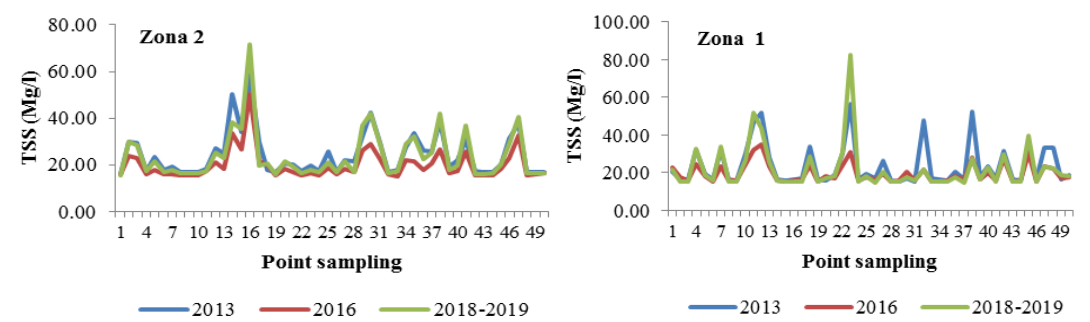
Figure 6. TSS (Mg / l) at each sampling point in Bontosua island as zona 1 and Ballang Caddi as zona 2, Spermonde waters in the east season on June-August 2013, 2016, and 2018-2019. According to Government Regulation No. 82